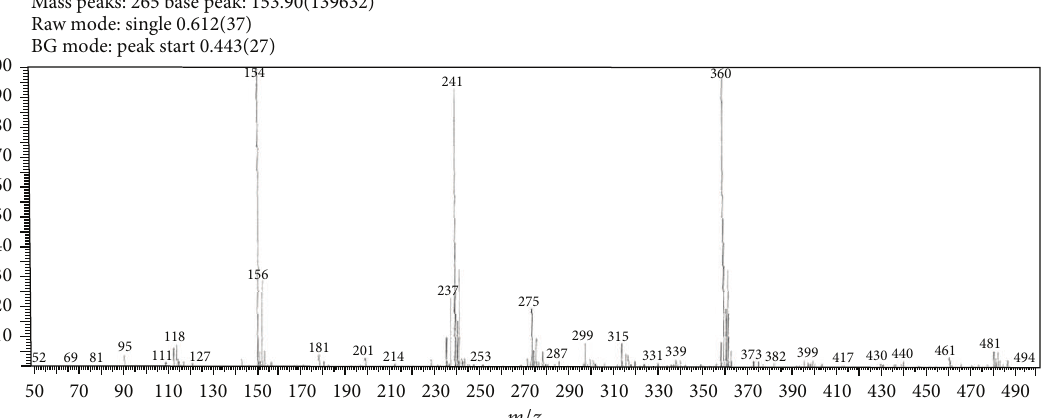
Figure 2: Mass spectrum of ligand